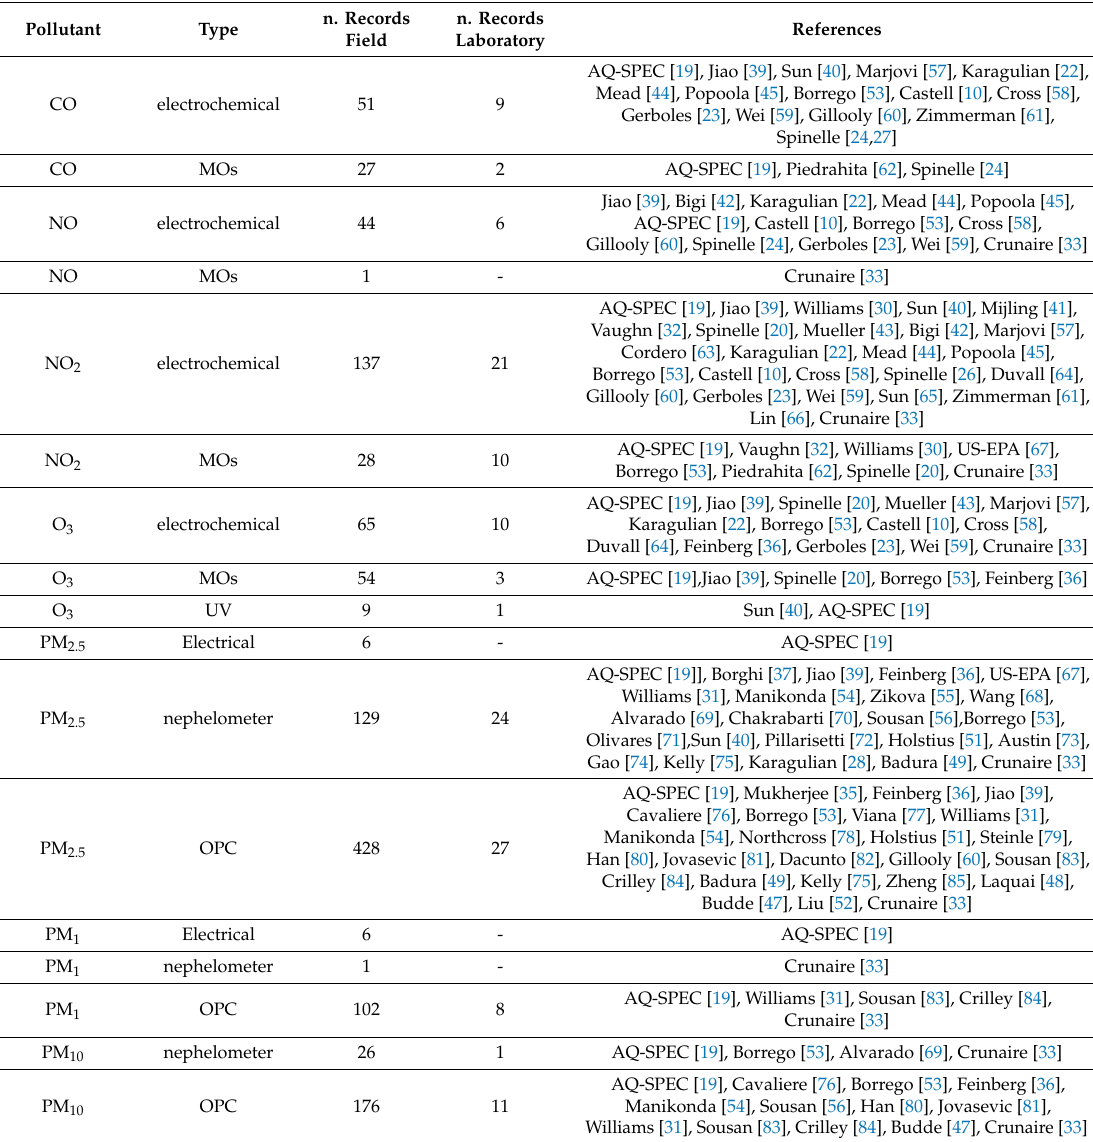
Table 1. Number of analyzed “records” for LCS by pollutant and by type of technology. n. Records Pollutant Type